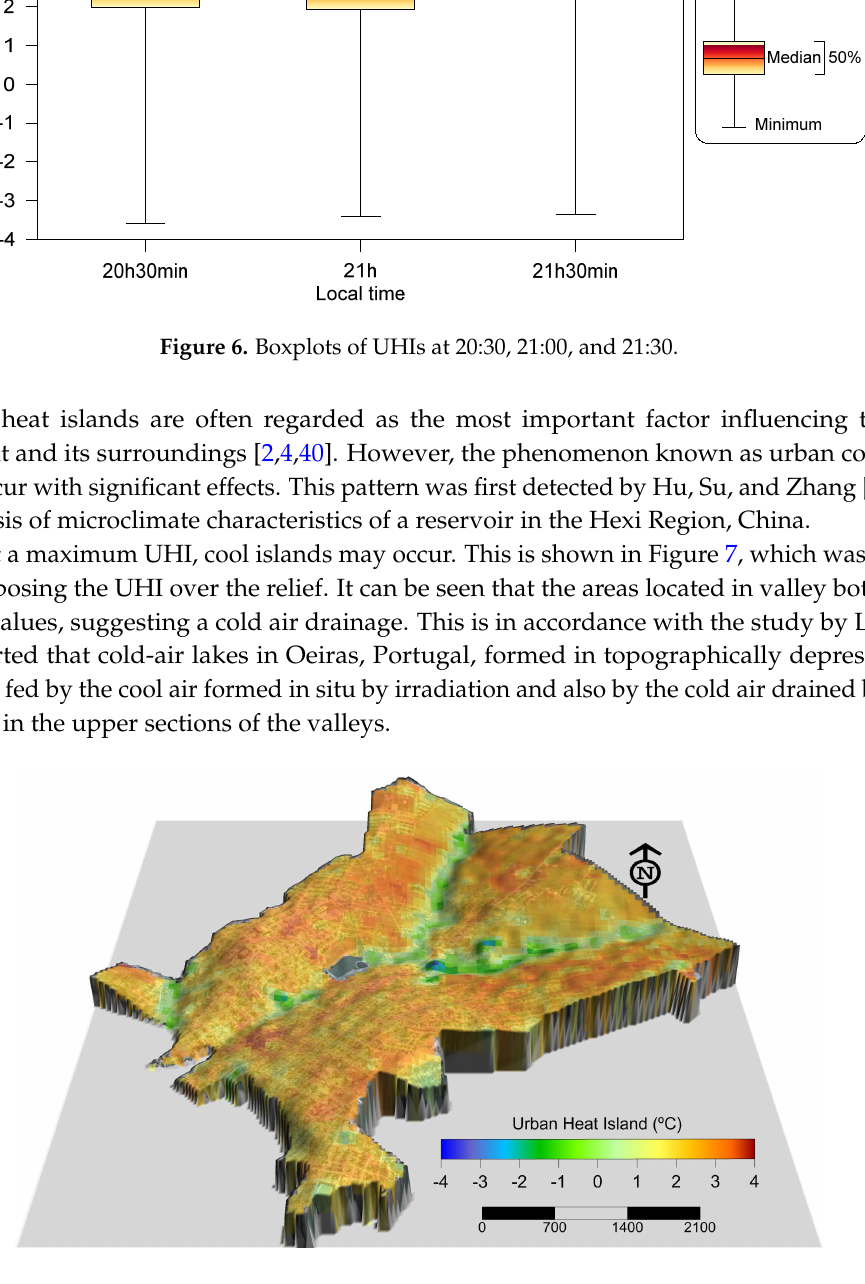
Figure 7. Maximum UHI intensities.